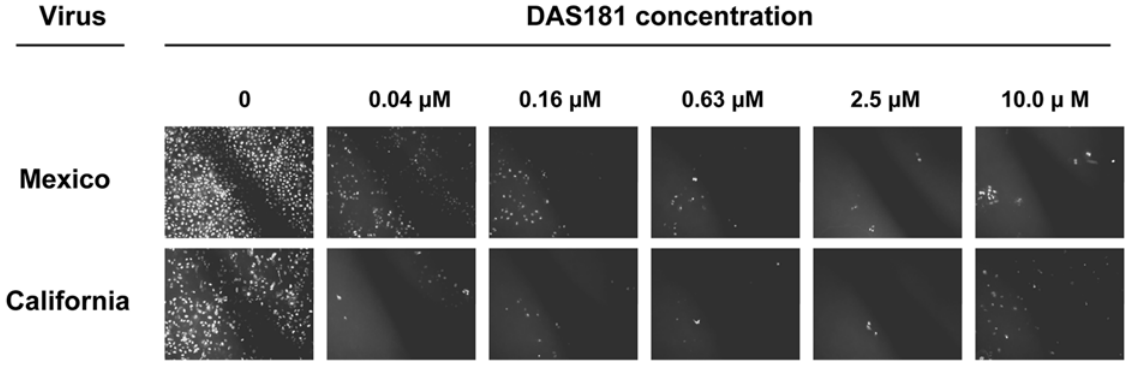
Figure 1. DAS181 inhibits pandemic IFV A(H1N1): Immunofluorescent detection of 2009 A(H1N1) foci in MDCK cells. MDCK cells were pretreated with DAS181 for 2 hours (at indicated concentrations) before infection with either pandemic influenza A(H1N1) A/Mexico/4604/09 (Mexico) or A/California/04/09 (California). After 24 hrs post-infection, the cultures were fixed and processed for immunostaining to detect virus antigen as marker of infected cells. White spots indicate infected cells that form foci (clusters) of different size ranging from 5 to 100’s of individual infected cells.